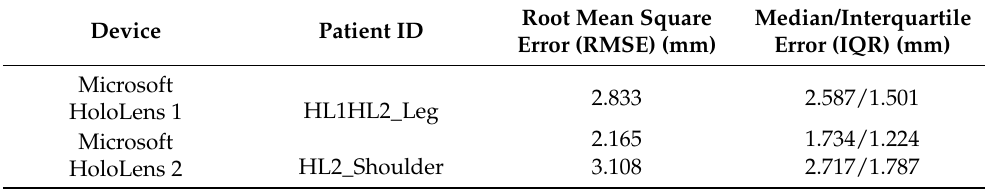
Table 2. AR projection errors divided by device and